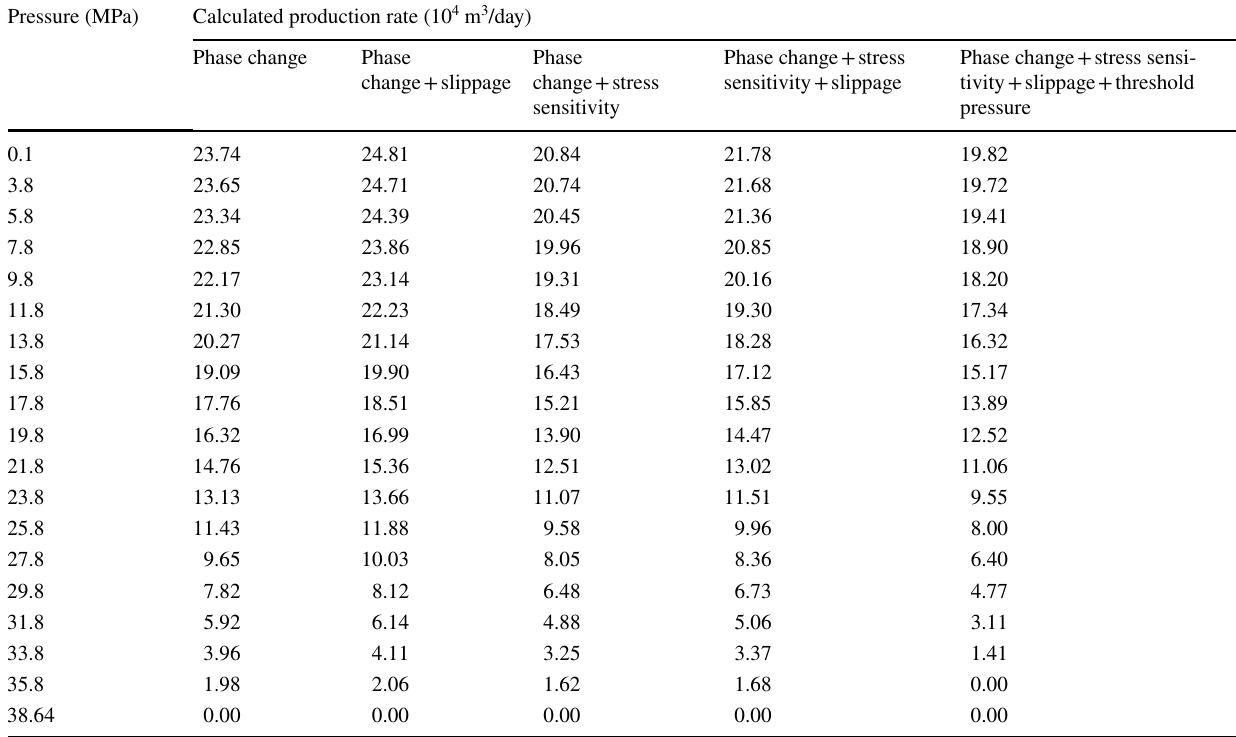
Table 3 Comparison table of productivity calculation results of a condensate gas well considering different factors Pressure